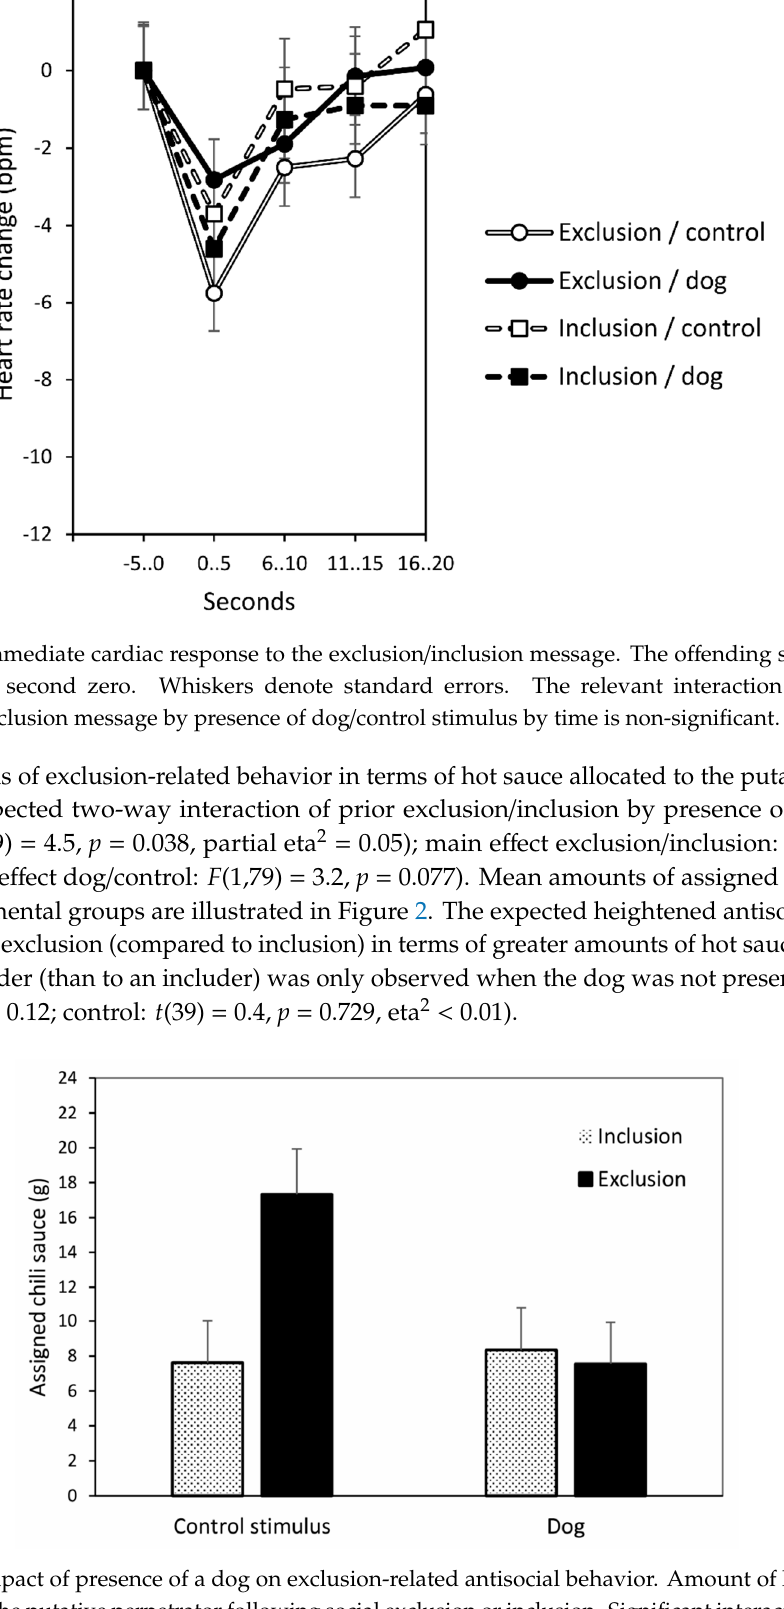
Figure 3. Immediate cardiac response to later insulting social-evaluative statement. Significant interaction effect of prior exclusion/inclusion by presence of dog/control stimulus by time. The essential difference is in the early part of the response (seconds 0–15). The offending statement occurred at second zero. Whiskers denote standard errors. The experience of social exclusion versus inclusion did not significantly influence how much hot sauce the participants assigned to themselves (main effect exclusion/inclusion: F (1,79) = 2.4, p = 0.122), and the presence of the dog did not moderate this relationship (interaction exclusion/inclusion x dog/control: F (1,79) = 1.2, p = 0.274). The correlations between perceived spiciness of the sauce (subjective rating) and the amount of chili sauce assigned to the putative other person was r = − 0.08,